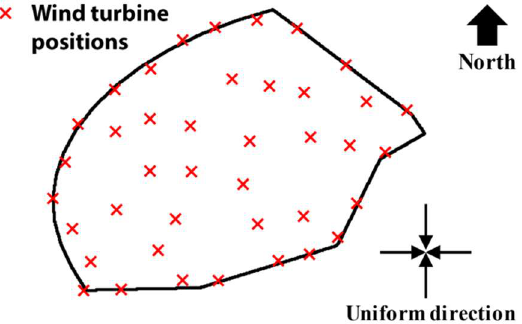
Figure 7. Results of wind farm layout optimization with different number of wind turbines under constant wind speed and variable wind directions: ( a ) wind farm power production and ( b ) wind farm power losses.